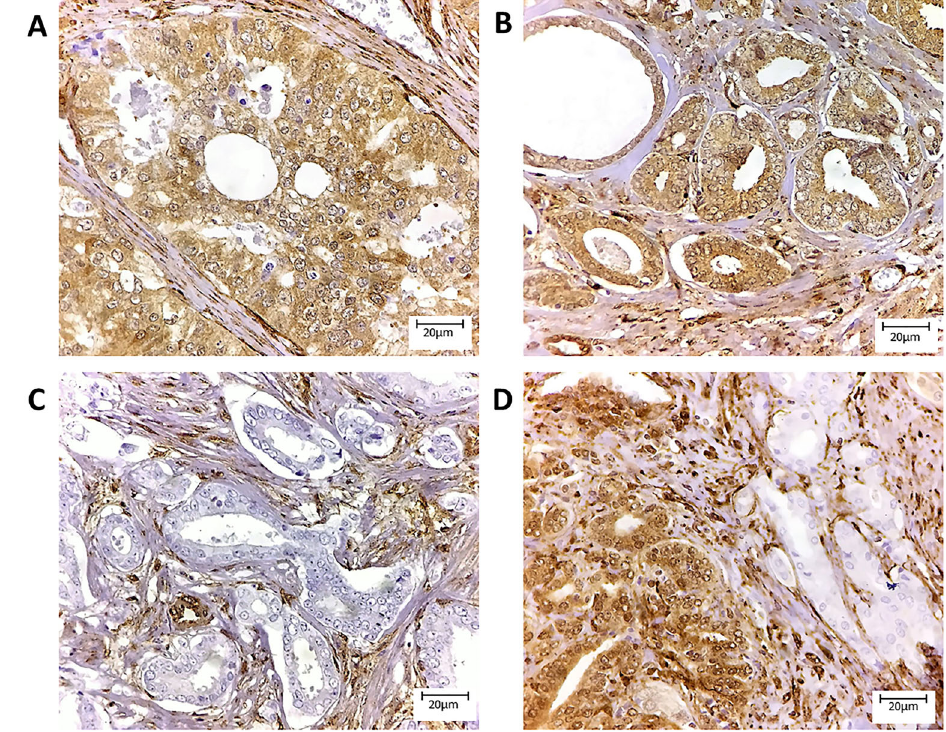
Figure 1. PTEN immunohistochemistry in prostate tissue showing several staining patterns on tissue microarray sections. A , Cribriform pattern with Gleason score 4 + 4 and positive cytoplasmic expression. B , Loose glands with Gleason Score 3 + 3 and cytoplasmic expression. C , Homogeneous PTEN loss on a Gleason score 3 + 3 tumor. D , Heterogeneous PTEN loss on Gleason Score 3 + 4 prostate tumor. Magni fi cation bar: 20 m m.